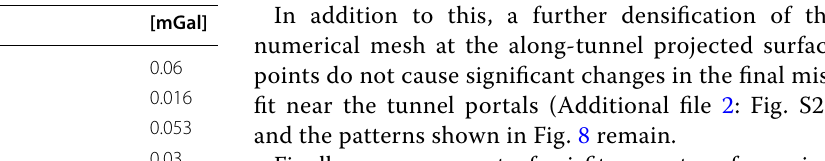
Table 5 Mean standard deviations in mGal associated with the gravity data products obtained from GRAVPROCESS during the processing of the raw gravity data acquired in the field Mean Standard